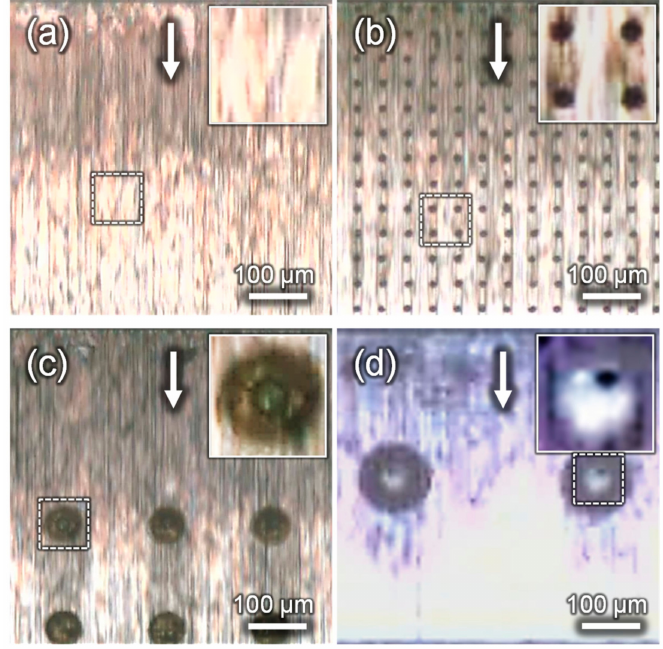
Figure 8. Captured images from in-situ observations at a punch stroke of 1.5 mm in bending with the ironing process using ( a ) the non-textured die and surface textured die with di ff erent dimple diameters of ( b ) 10 µ m, ( c ) 50 µ m and ( d ) 100 µ